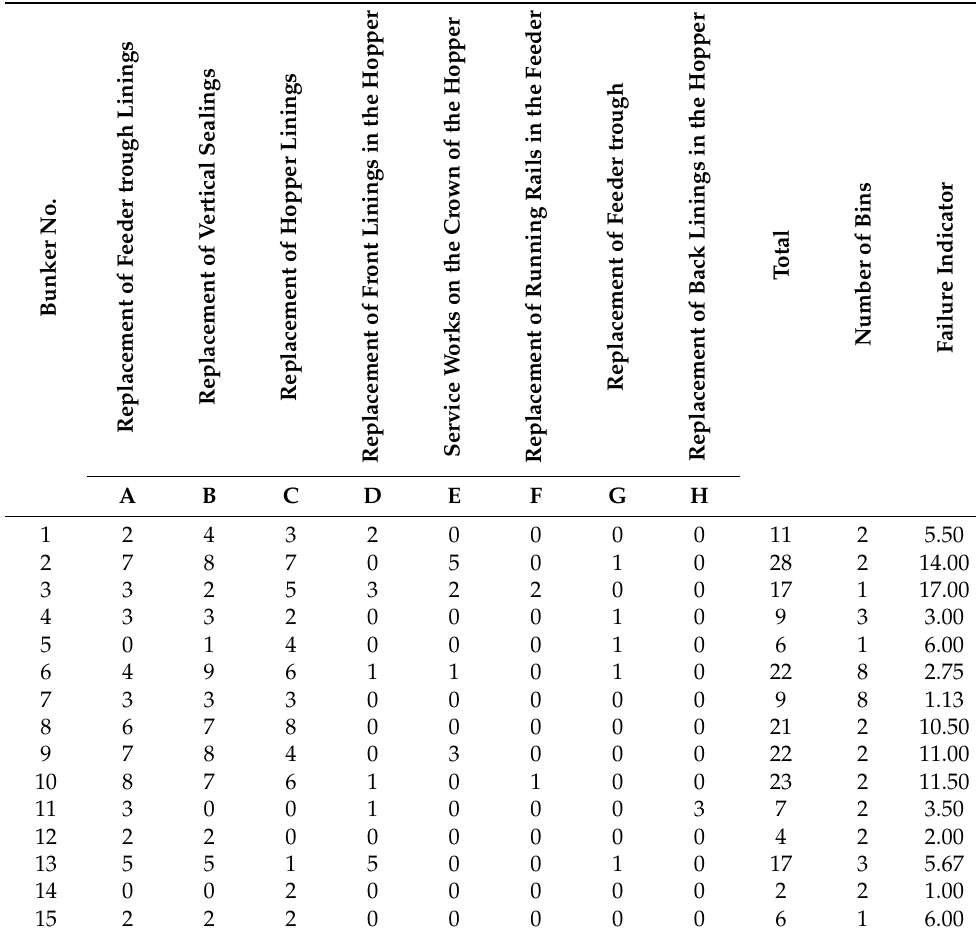
Table 3. Number of repairs in retention bunkers